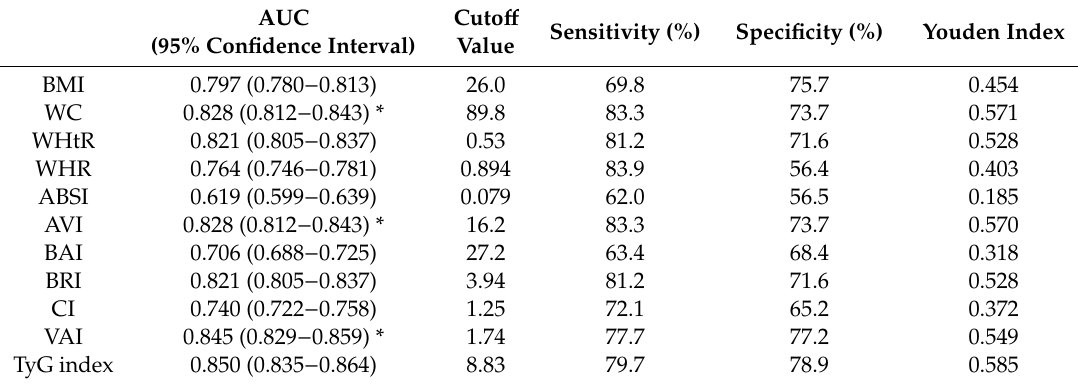
Table 3. Area under curve (AUC), cuto ff value, Youden index, sensitivity and specificity of 11 obesity-related indices for predicting MetS in men.